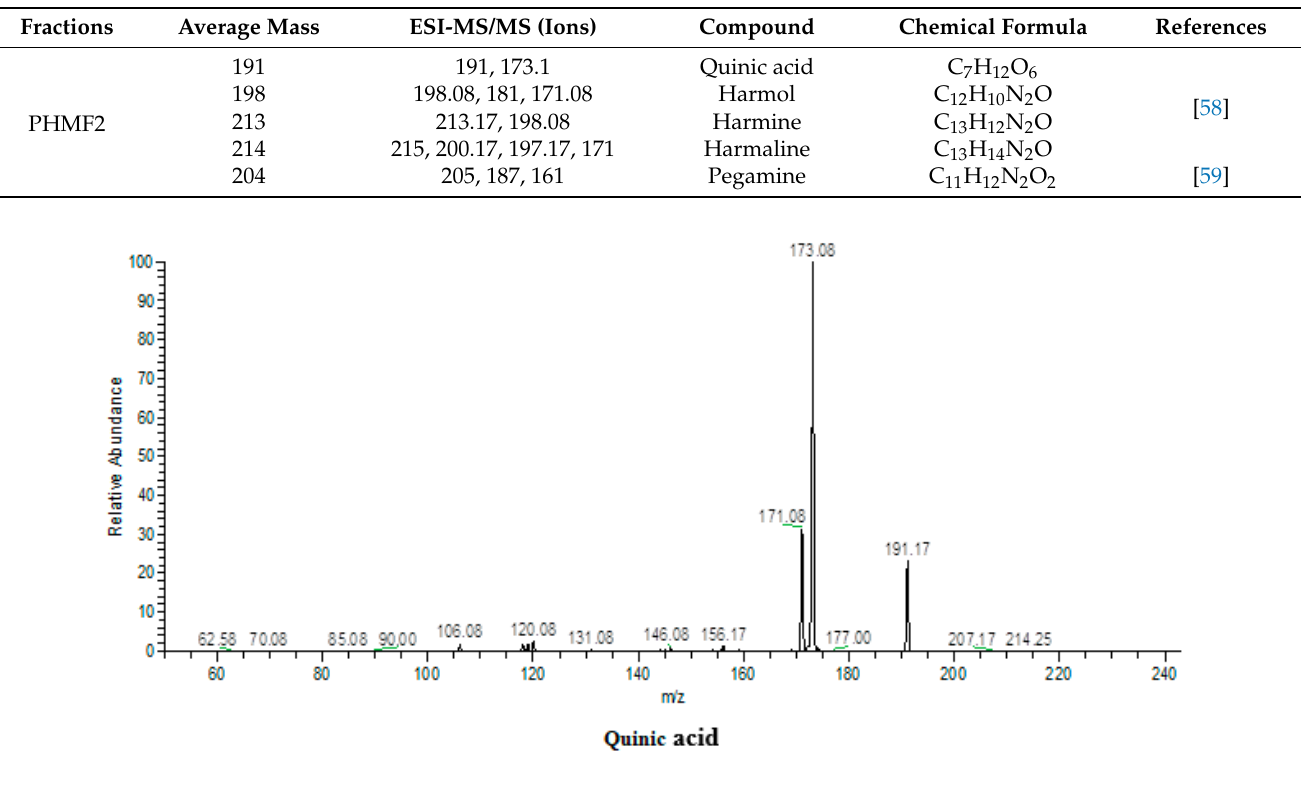
Table 4. LC-ESI-MS/MS identification of bioactive compounds from PHMF2 of Peganum harmala .